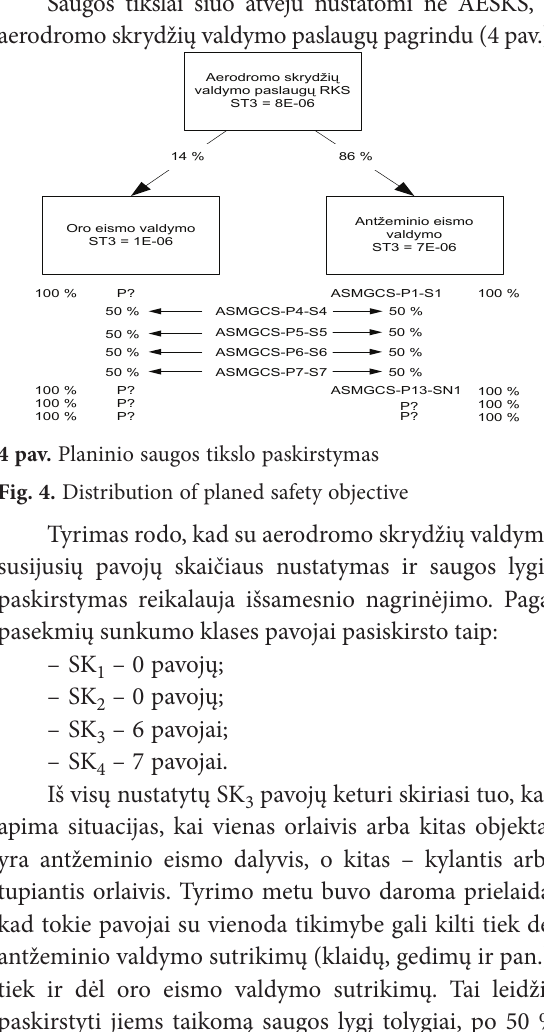
Table 2. Vilnius A-SMGCS risk classification scheme Sunkumo klasė